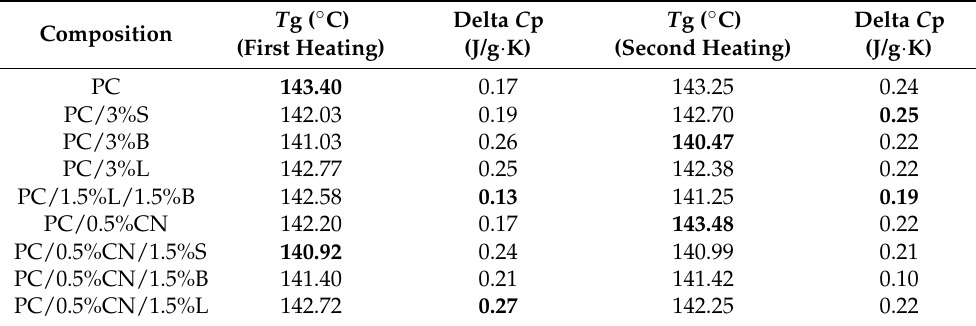
Table 6. Summary of T g and Delta C p changes after the first and second heating steps of the individual